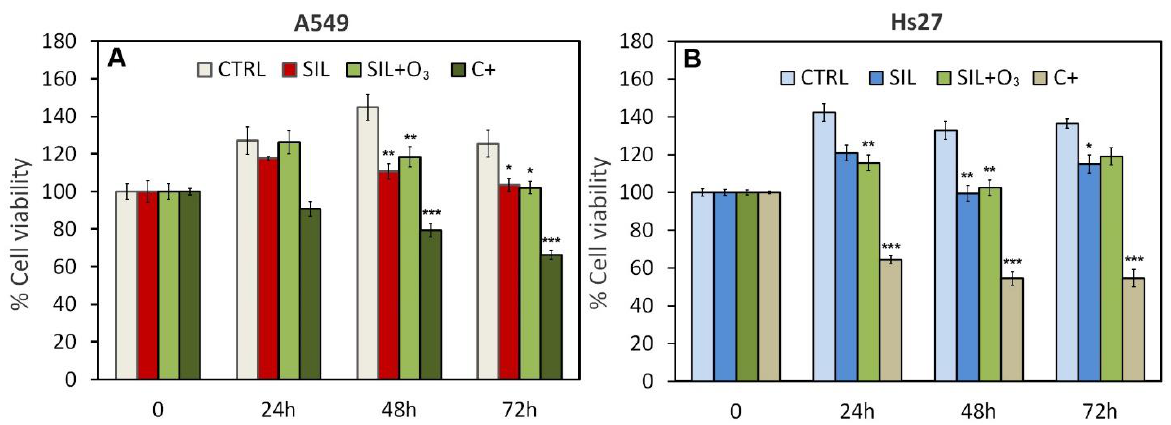
Figure 3. MTS assay in cell lines A549 ( A ) and ( B ) Hs27. Effects of silica (40 µg/h) and silica/ozone (120 ppb) on A549 and Hs27 at 24, 48, 72 h. Triton X-100 (0.1%) was used as positive control. Significance values were determined according to the Student t -test: * = p < 0.05; ** = p < 0.005; *** = p < 0.0005. All treated were compared to their respective controls. Error bars are the standard error of the mean.